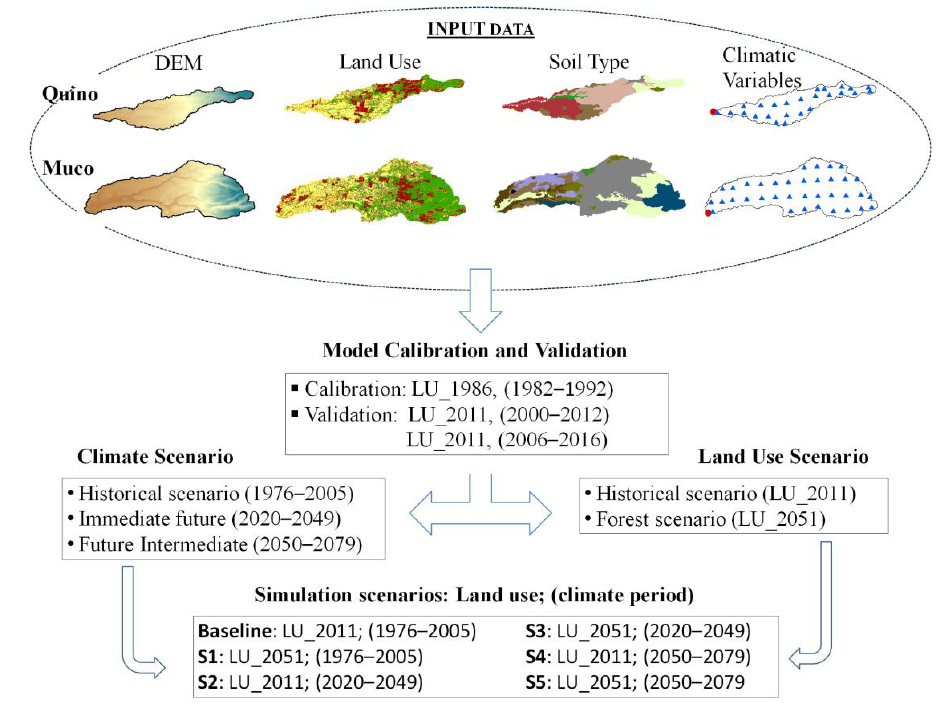
Figure 2. Hydrological simulation methodology.